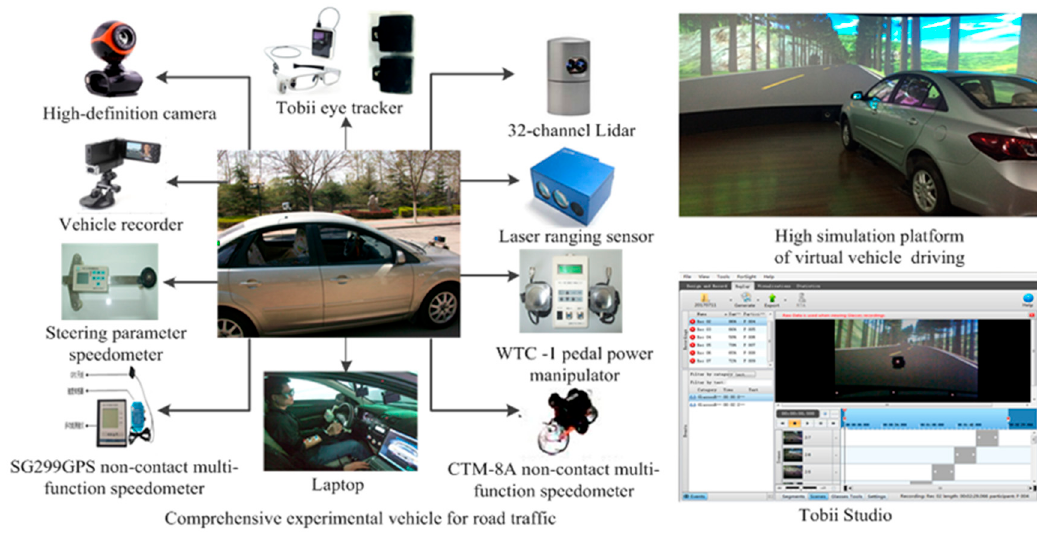
Figure 3. Parts of the experiment instruments.